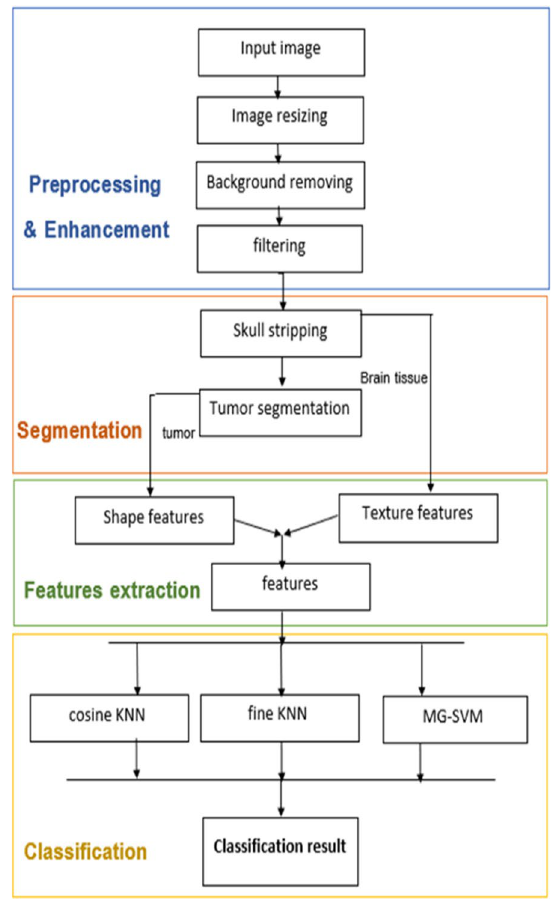
Fig. 1 The proposed method flow